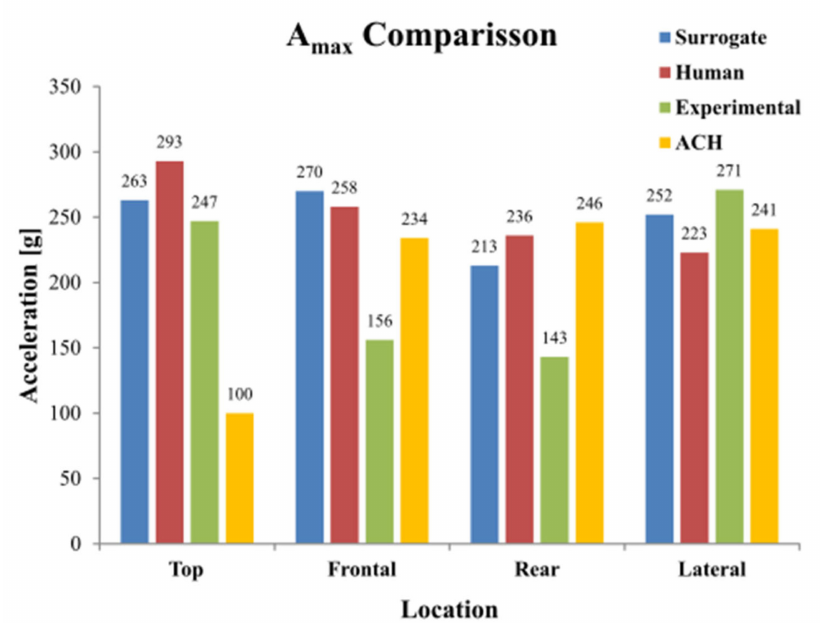
Figure 11. PLA of both head models and experimental data for each impact location using the head surrogate, the human head model, experimental data, and an advanced combat helmet (ACH).